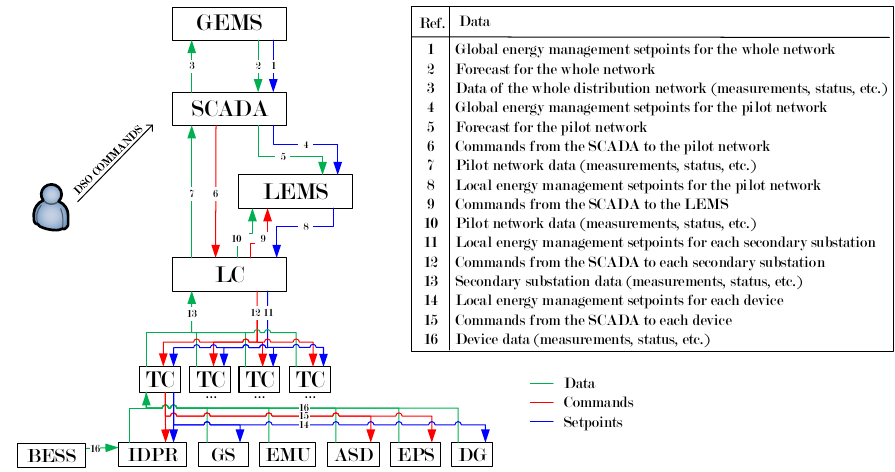
Figure 5. The hierarchy of